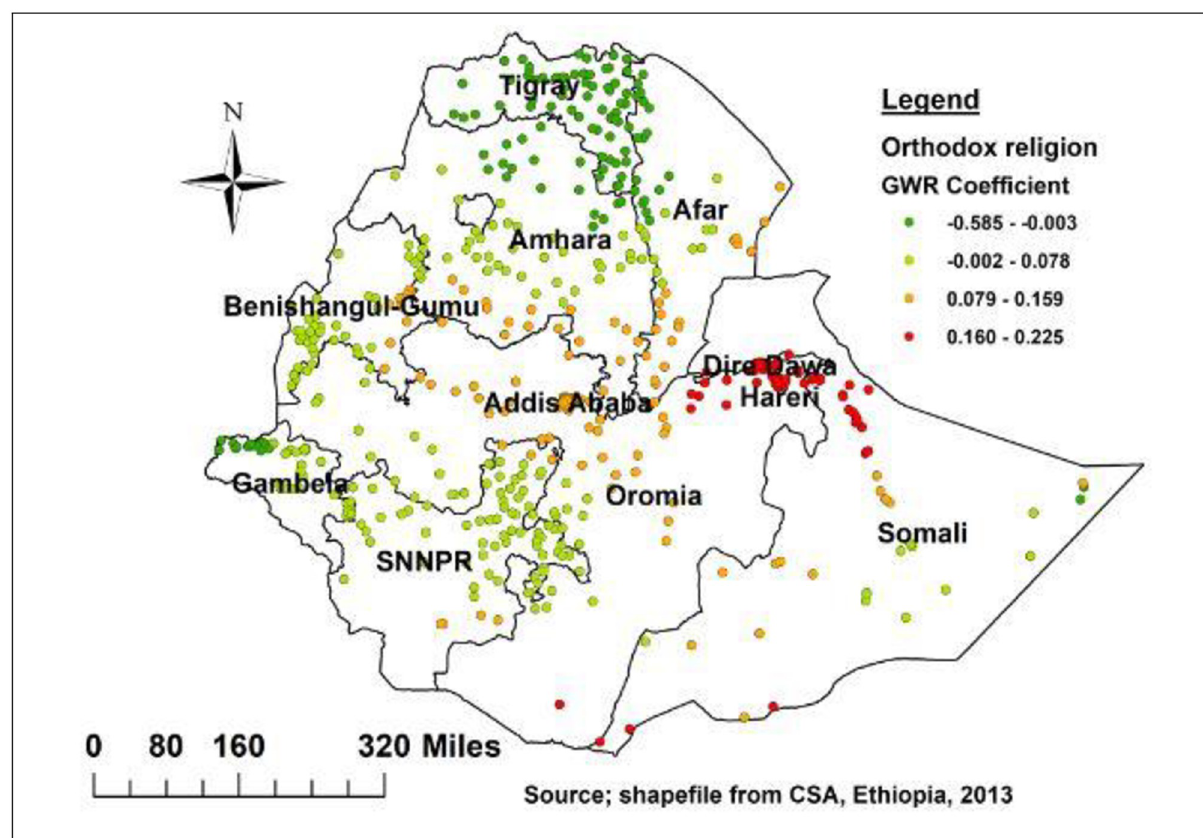
Fig 6. Geographically weighted regression coefficients for orthodox religion to predict the hotspots of delayed breastfeeding in Ethiopia.